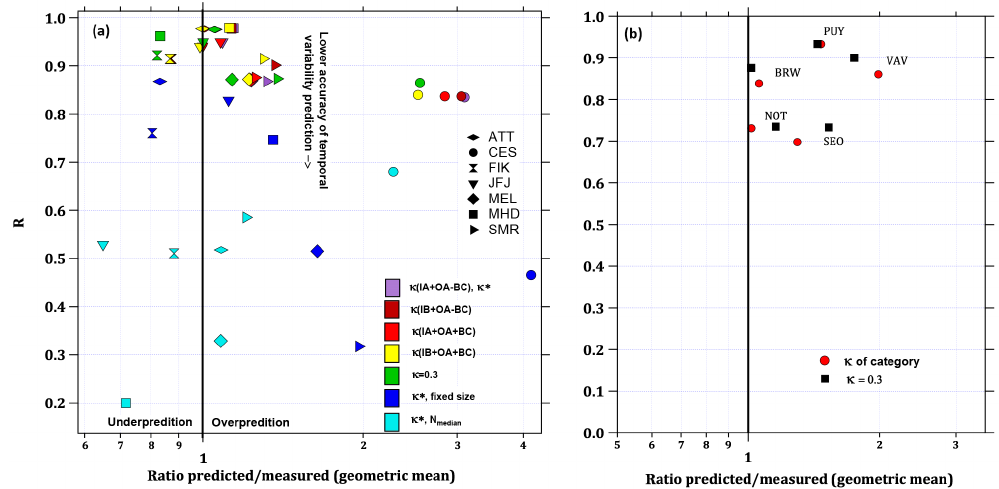
Figure 10. (a) Results from closure studies for the seven stations with aerosol chemical composition data. The coefficient of the correlation between predicted to measured CCN number concentration at SS = 0.5% is shown in the vertical axis while the geometric mean of the ratio of predicted and measured CCN number concentration is given on the horizontal axis. The different marker symbols represent the stations while the colours indicate details of the closure study. Kappa values refer to how the hygroscopicity parameter was calculated as described in Sect. 2.3.2 and as listed in Table 2. “Fixed size” refers to closure studies where the fixed average shape of all size distributions from the data set was applied while keeping the temporally variable particle number concentrations as measured at each station. “ N median ” means that closure studies were performed fixing the particle number concentration at each station to its median value while keeping the temporally variable shape of the size distribution. (b) Closure results for all stations without chemical composition data using κ = 0.3 and an average kappa per site category – VAV: rural background, κ = 0.48; PUY: alpine, κ = 0.41 (e.g. JFJ); BRW and NOT: coastal background, κ = 0.55; SEO: urban, κ = 0.1.